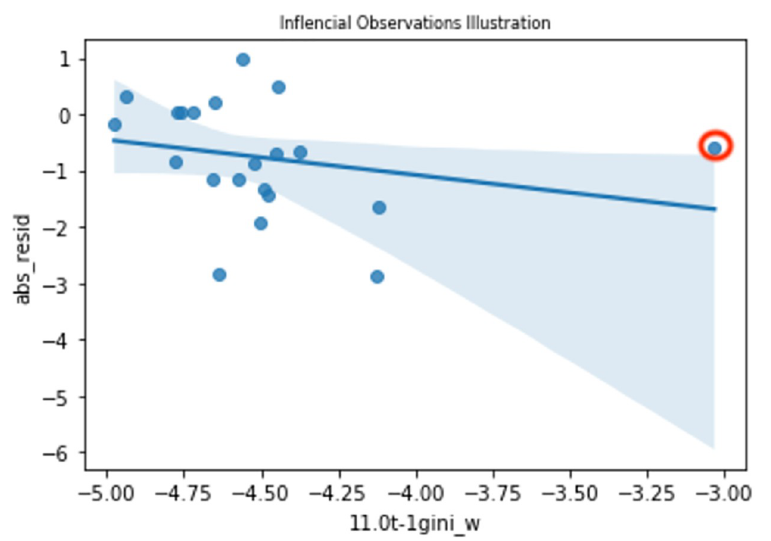
Fig 5. Illustration of influential